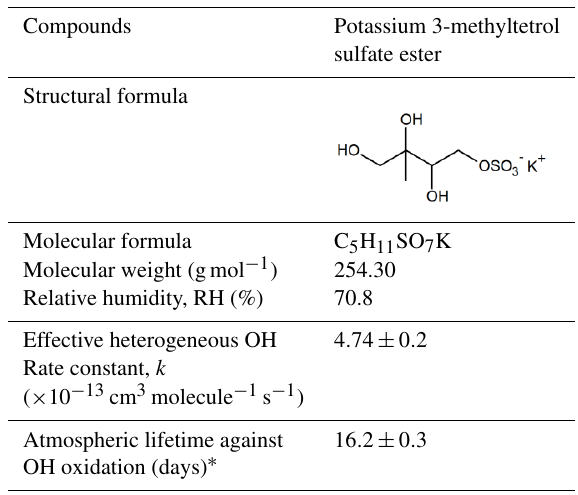
Table 1. Chemical structure, properties, effective heterogeneous OH rate constant and atmospheric lifetime against the OH radical of potassium 3-methyltetrol sulfate